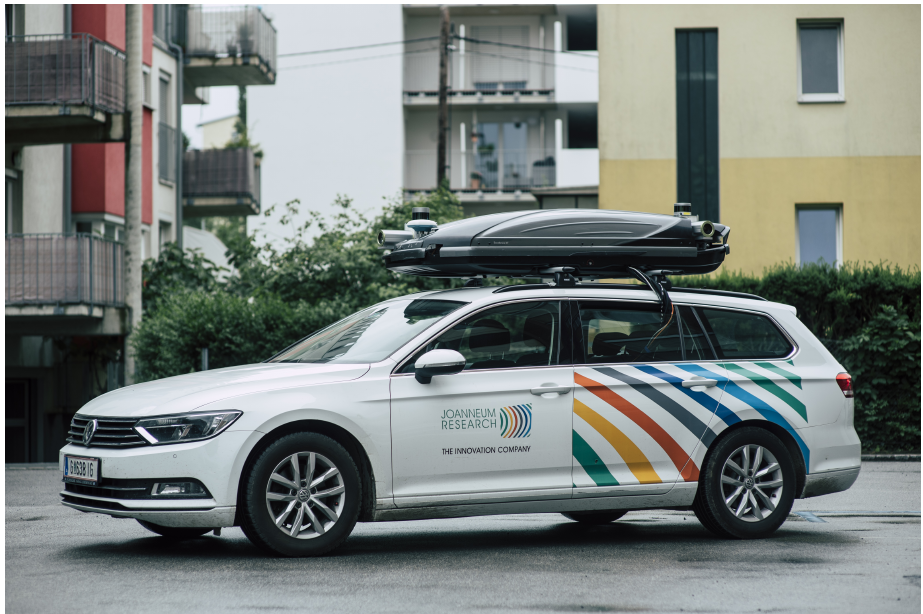
Figure 17. Joanneum Research DGT System. Photo